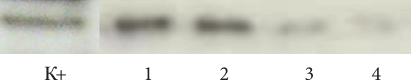
Figure 2: Immunoblotting analysis of K. pinnata extracts. ( P +) synthetic Cec ` 1, Mr = 3.4 kDa (30ng); (1) K. pinnata transgenic line 1 after the cold stress; (2) K. pinnata transgenic line 2 after the cold stress; (3) K. pinnata transgenic line 2 before the cold stress; (4) K. pinnata transgenic line 2 before the cold stress.